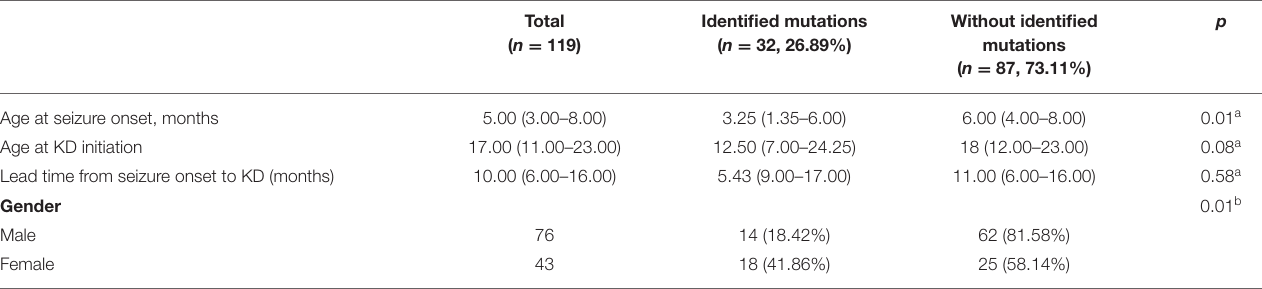
TABLE 2 | Demographics of patients and comparison between patient with and without identified mutations at 16-weeks after KD (3:1) initiation.